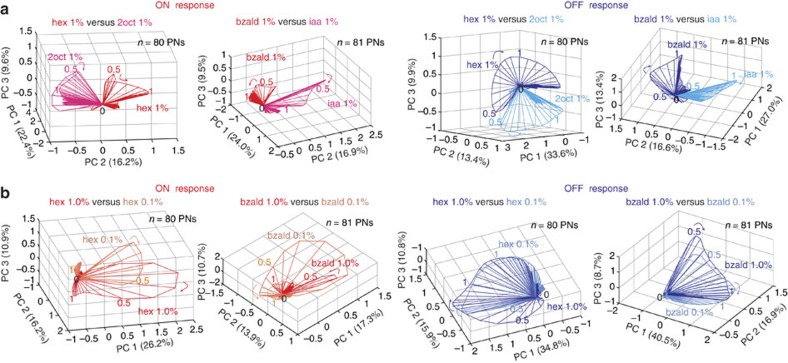
OFF responses vary with identity and intensity.(a) Comparison between ON response trajectories evoked by two different odorants is shown after dimensionality reduction for two different odour pairs (left panel; hex versus 2oct and bzald versus iaa). Similar comparison between the OFF response trajectories for the same pairs of odorants are shown in the right panel. The ON and the OFF response trajectories were generated and shown separately for clarity. Note that each odorant evoked a distinct response trajectory during both these epochs. (b) Similar plots as shown in a but now comparing responses evoked by the same odorant at two different intensities (hex 1% versus hex 0.1% and bzald 1% versus bzald 0.1%).